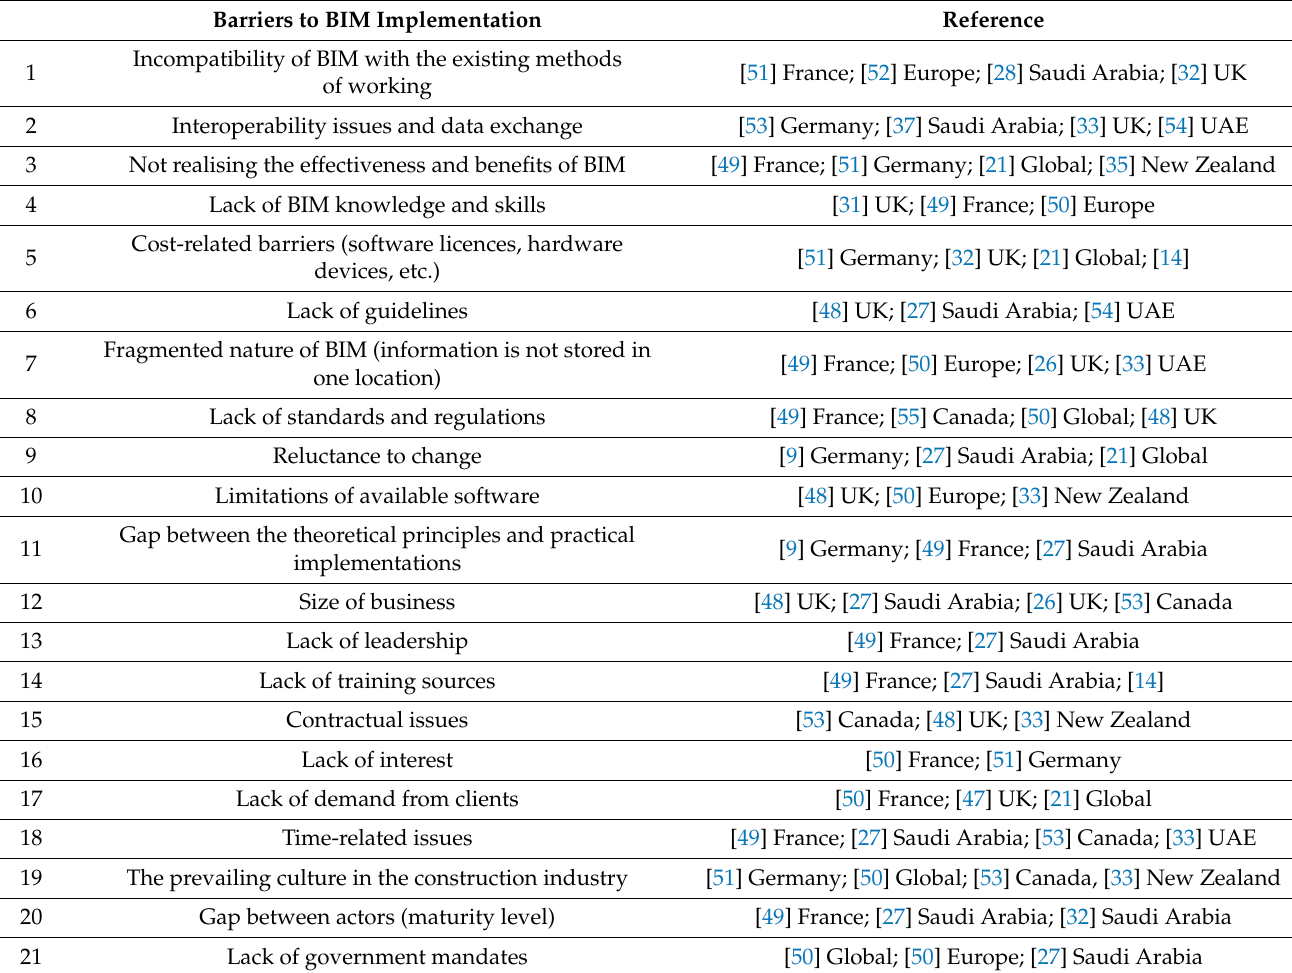
Table 1. Barriers to BIM implementation as identified from the